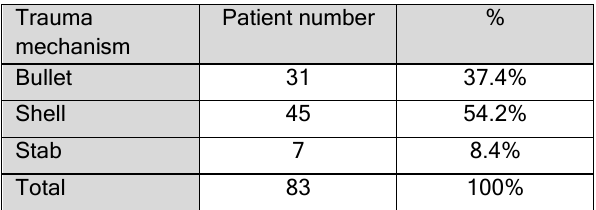
Table (3)Distribution of patient in relation to trauma mechanism